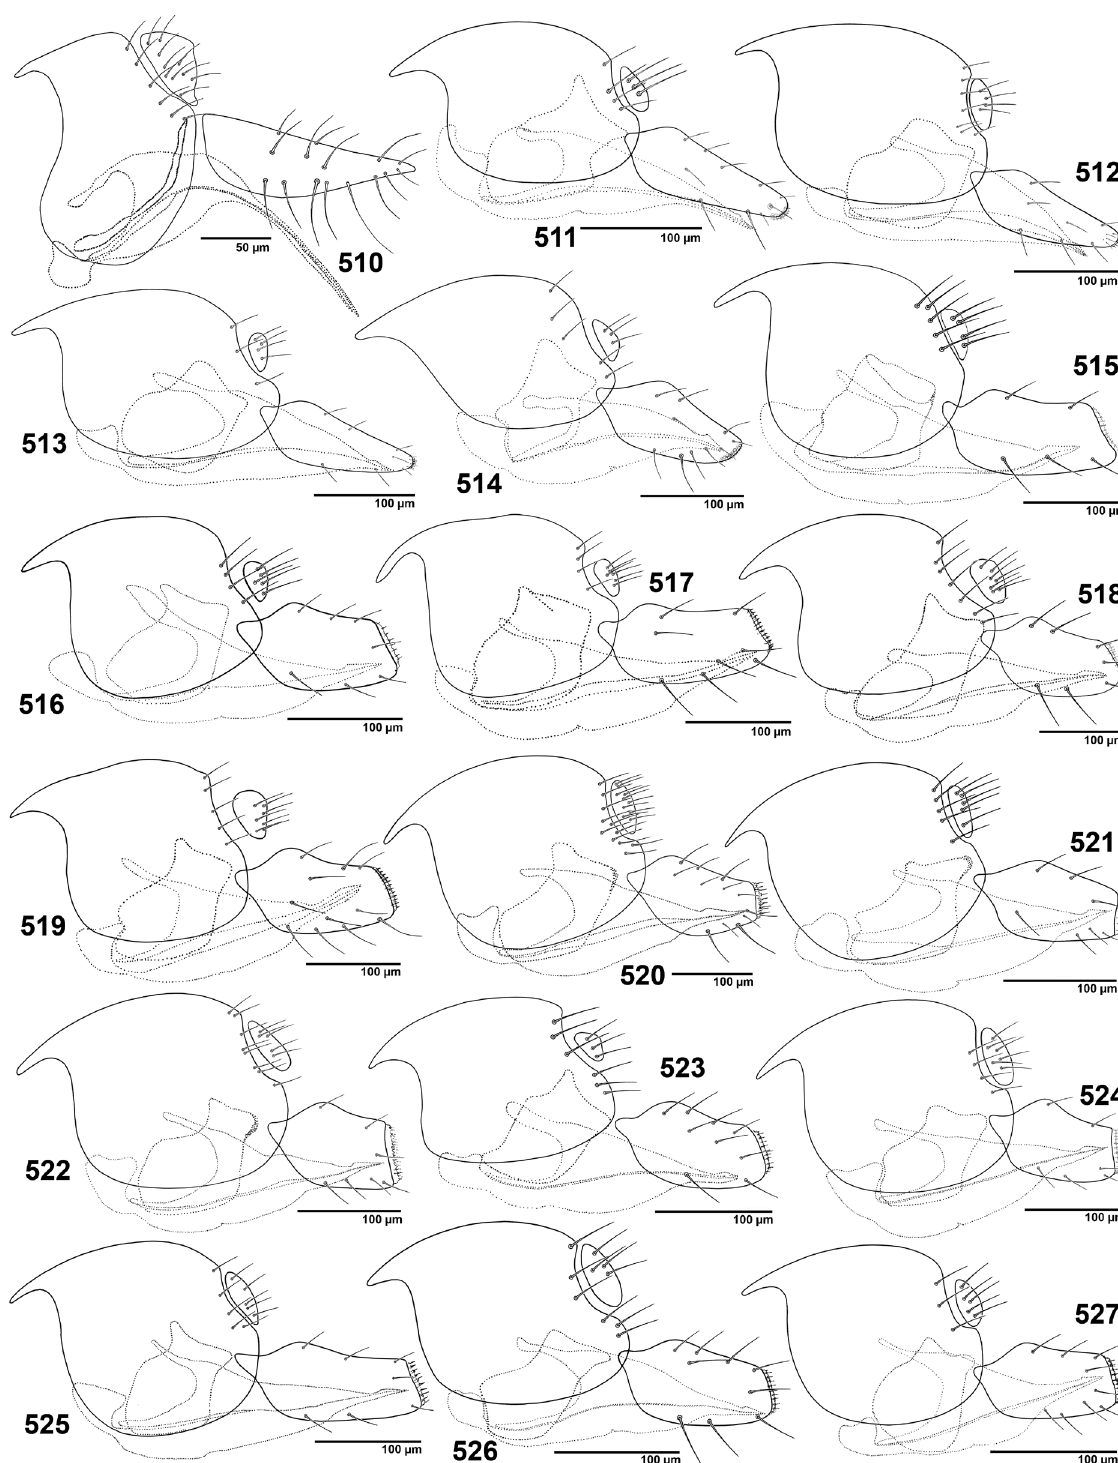
Figs 510–527. Lateral aspect of ♀ genitalia: 510 . Aclitus obscuripennis . 511 . Adialytus ambiguus . 512 . Adialytus salicaphis . 513 . Adialytus thelaxis . 514 . Adialytus veronicaecola . 515 . Aphidius absinthii . 516 . Aphidius arvensis . 517 . Aphidius asteris . 518 . Aphidius avenae . 519 . Aphidius banksae . 520 . Aphidius cingulatus . 521 . Aphidius colemani . 522 . Aphidius eadyi . 523 . Aphidius eglanteriae . 524 . Aphidius ervi . 525 . Aphidius funebris . 526 . Aphidius hieraciorum . 527 . Aphidius iranicus